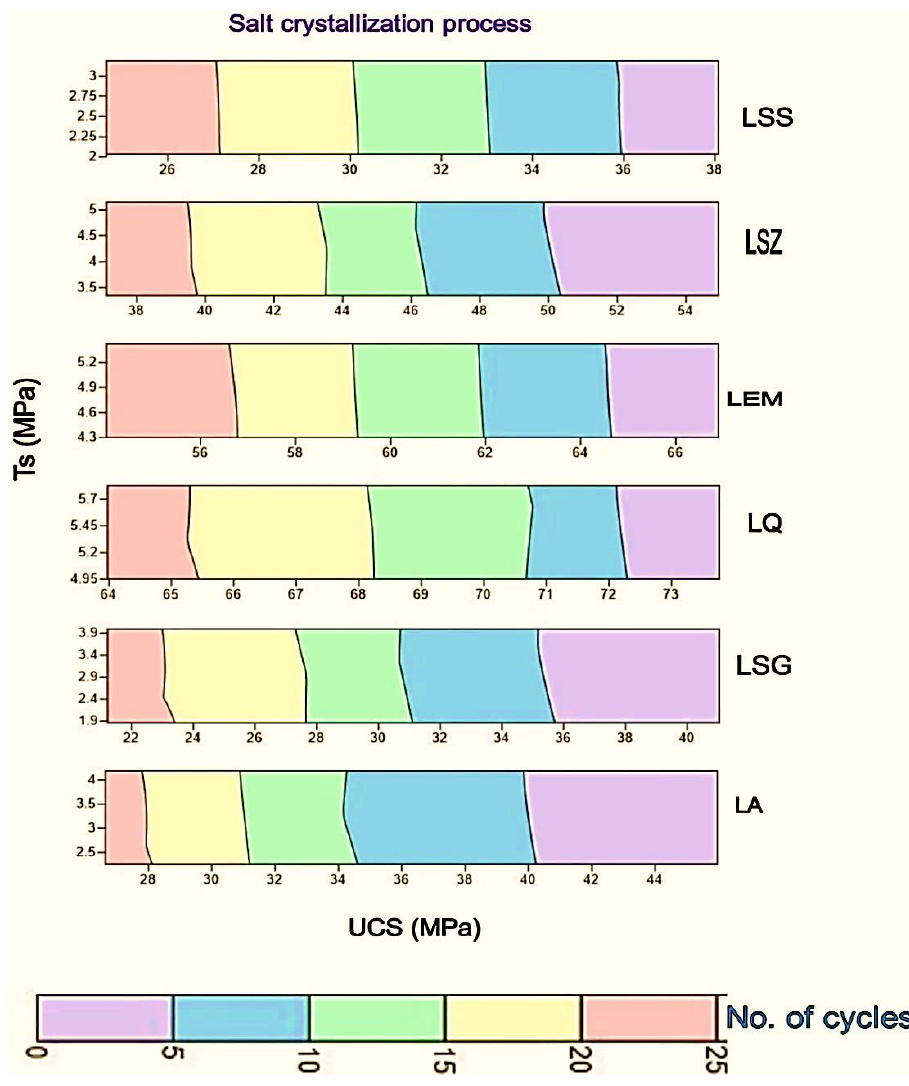
Figure 6. Relationships between TS and UCS values and number of salt crystallization cycles.